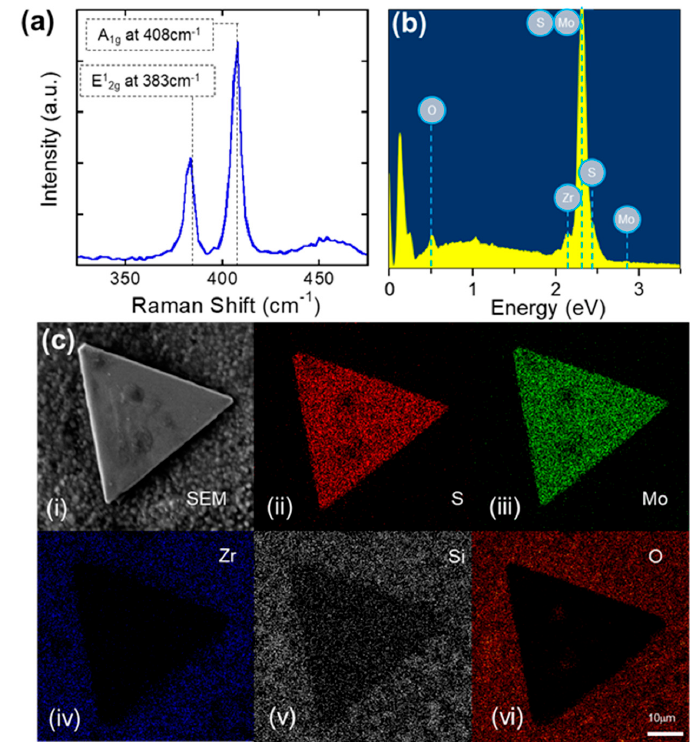
Figure 3. ( a ) Raman spectrum and ( b ) EDX of MoS 2 crystals grown at 800 °C. ( c ) (i) SEM image, and EDX mapping images of MoS 2 crystals consists of (ii) S, (iii) Mo, (iv) Zr, (v) Si, and (vi) O atoms from a SiO 2 coated flexible YSZ substrate.